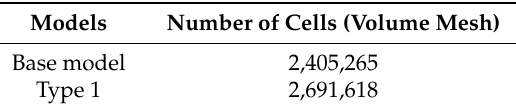
Table 2. Meshing